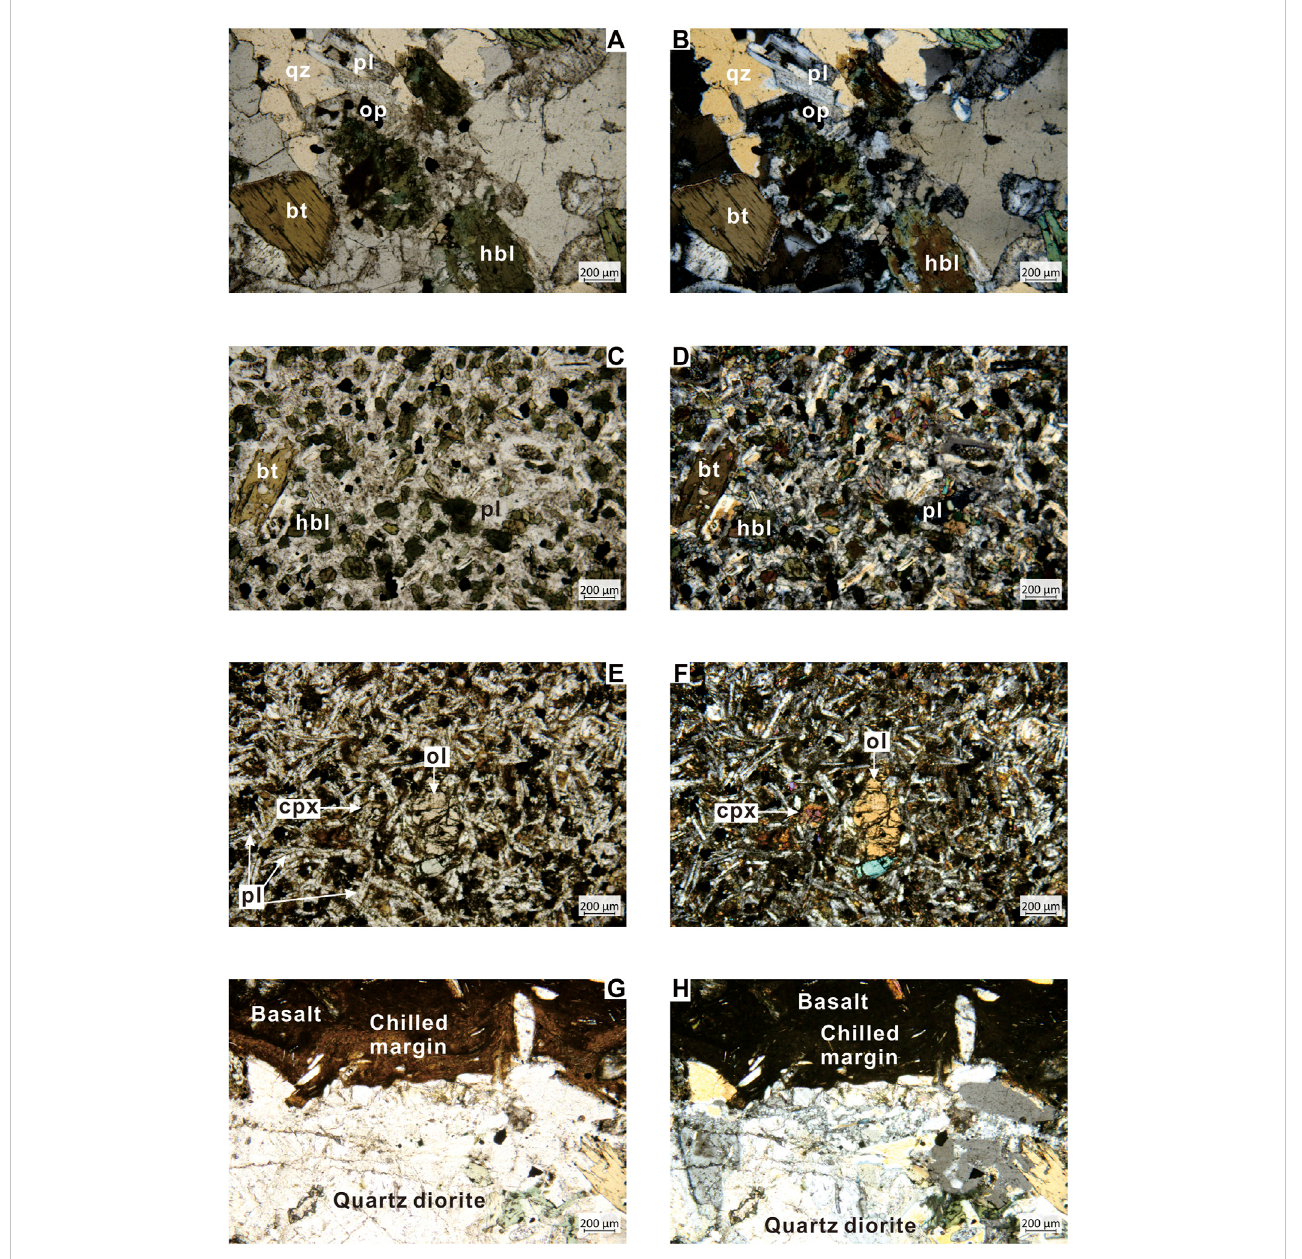
FIGURE 4 Photomicrographs of the rocks of the Snoul pluton. (A) Plane polarized light and (B) crossed polarized photos of the quartz diorite (A17-3a). (C) Plane polarized lightand (D) crossed polarized photos of adioriteenclave(A17-13). (E) Plane polarized lightand (F) crossed polarizedphotos ofabasaltic rock (A15- 1b). (G) Plane polarized light and (H) crossed polarized photos of the chilled margin between the quartz diorite and basalt. Symbols: qz = quartz, bt = biotite, pl=plagioclase,op=opaque,hbl=hornblende,ol=olivine,cpx=clinopyroxene.WholerockgeochemicaldatawerenotmeasuredforsamplesA17-3a or